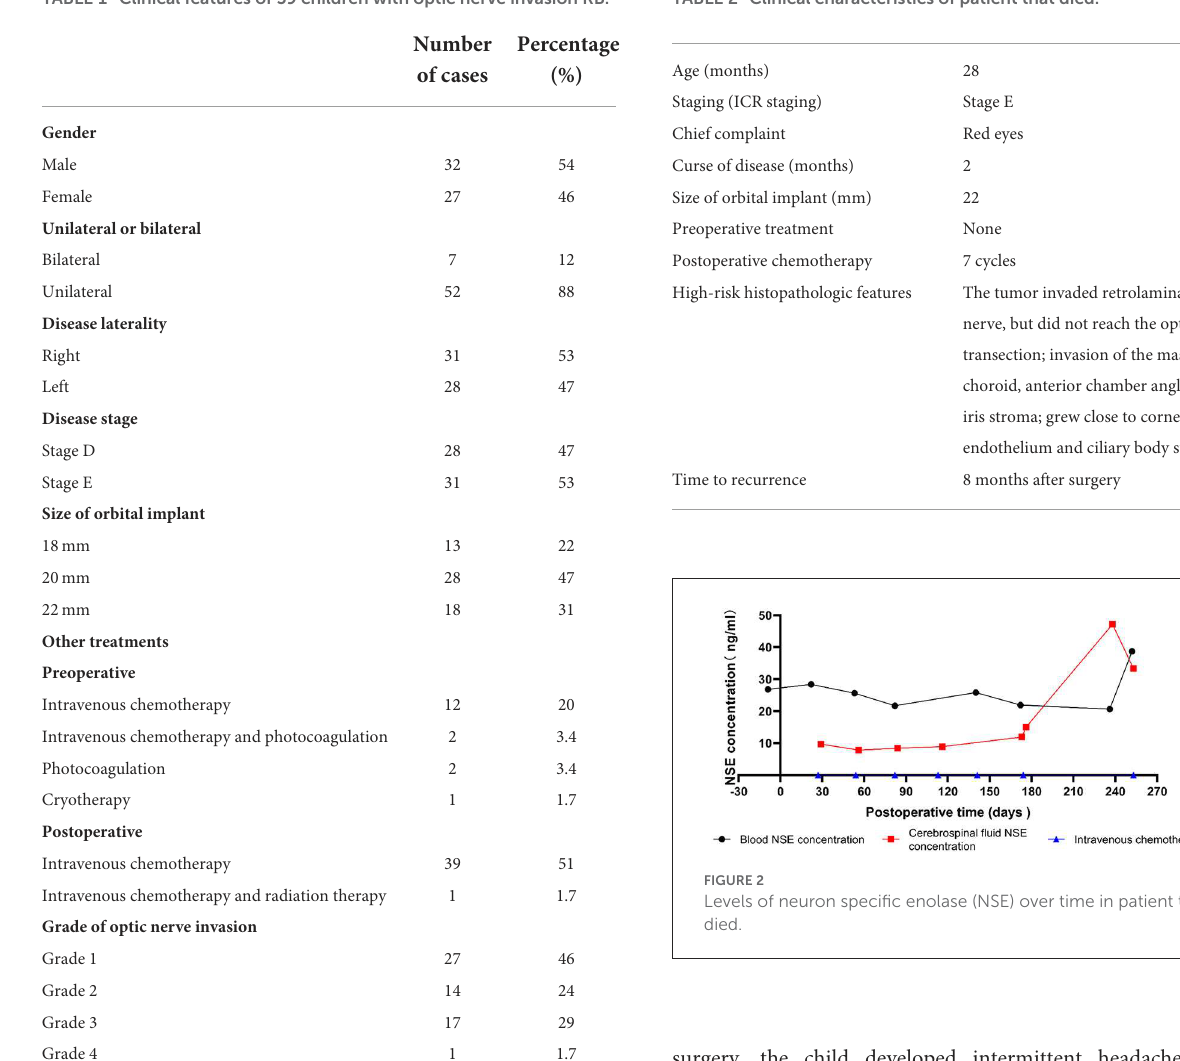
surgery, the child developed intermittent headaches with vomiting, they had a significant increase in cerebrospinal fluid neuron-specific enolase (NSE) (Figure 2), and MRI showed a mass shadow in the left orbit, which was considered tumor recurrence. (Table 3, Figure 3). One patient had orbital implant exposure on the 10th day after surgery. The child underwent orbital implant exposure repair and recovered well. Another patient developed orbital cellulitis 4 months after surgery but improved with treatment with anti-inflammatory and anti-infective therapy. Two additional children developed blepharoptosis at 4 or 7 years after surgery. Another child developed a granuloma 9 years after surgery and blepharoptosis 10 years after enucleation. Yet another child developed a subconjunctival cyst 2 years after surgery. Six more children had enophthalmos and superior sulcus deformity, four of whom had an 18mm orbital implant and two that had a 20 mm orbital